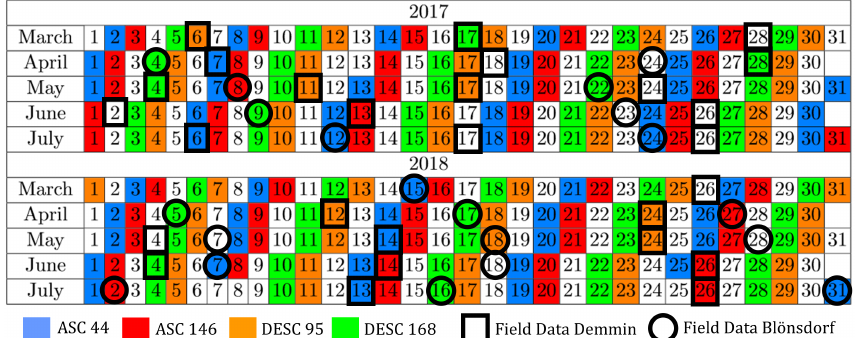
Figure 2. Sentinel-1 acquisitions and field measurement dates 2017 and